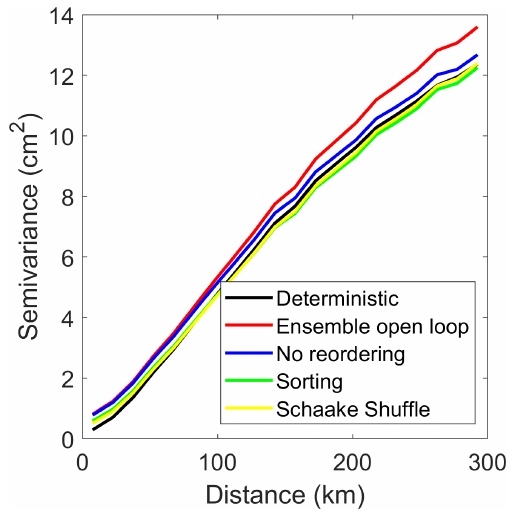
Figure 3. Variograms of the estimated snow water equivalent (SWE) on 28 February